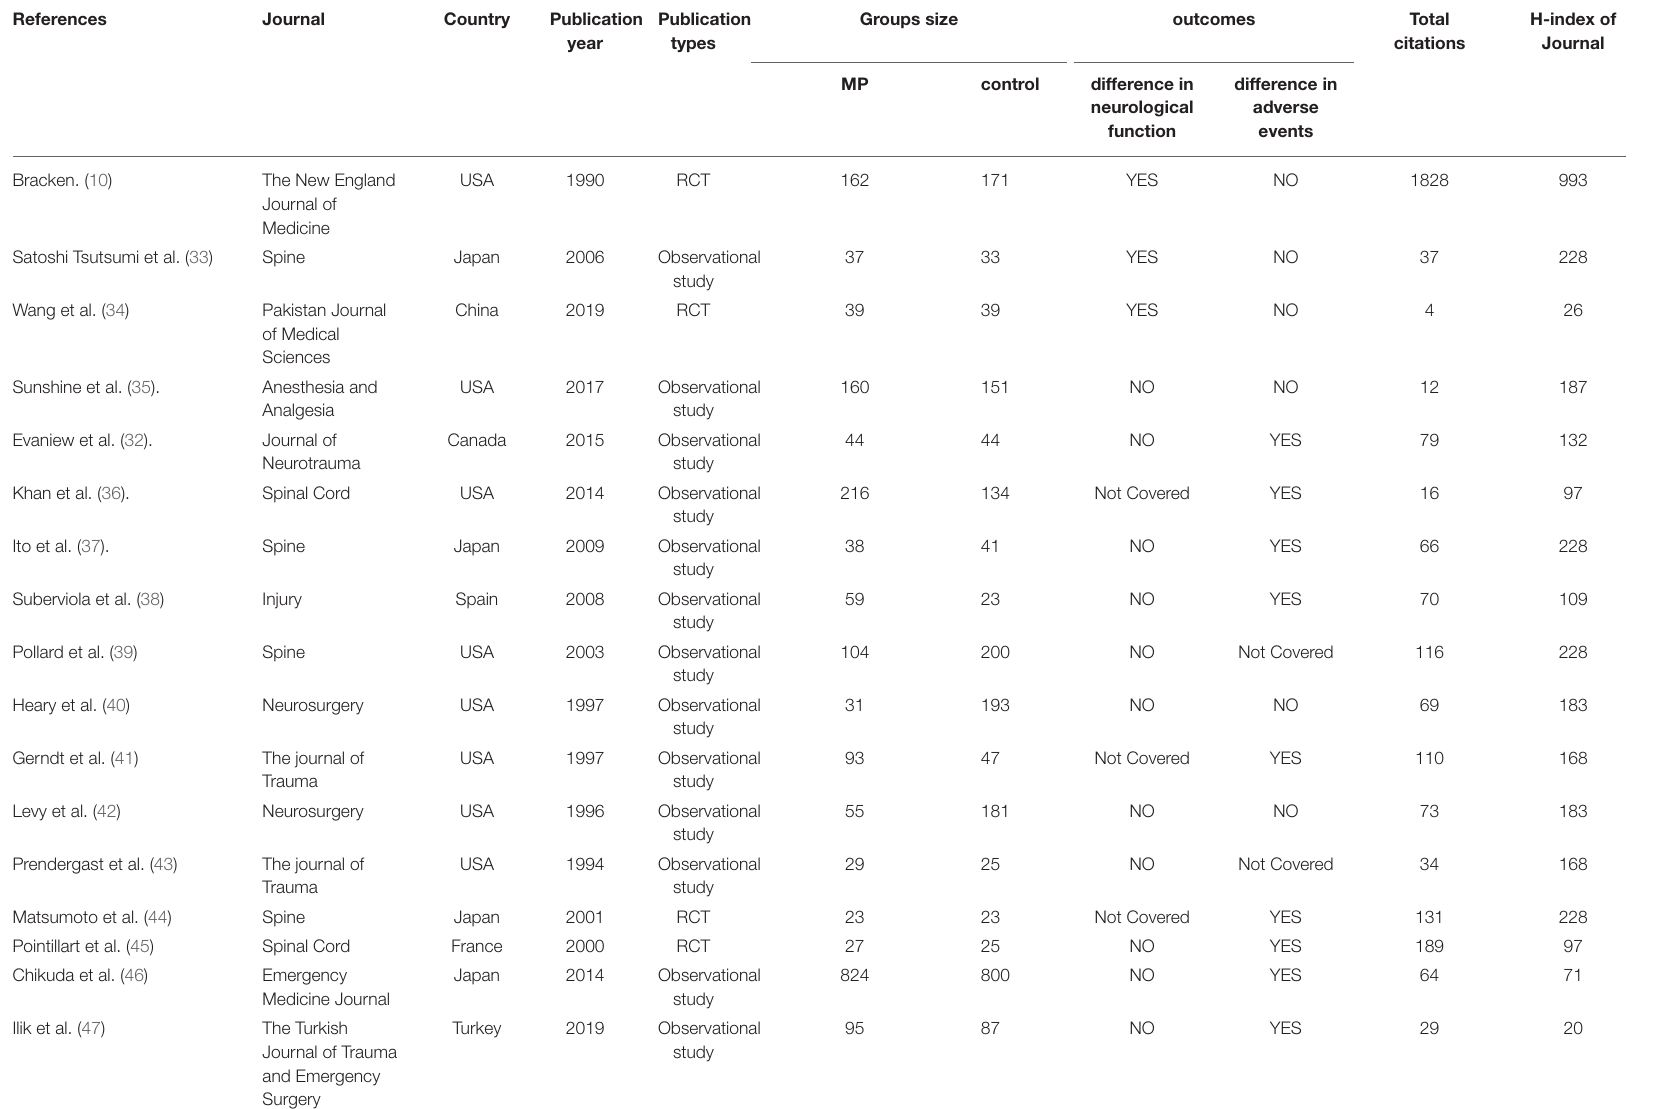
TABLE 3 | Literature comparison methylprednisolone applied to clinical outcomes of patients with